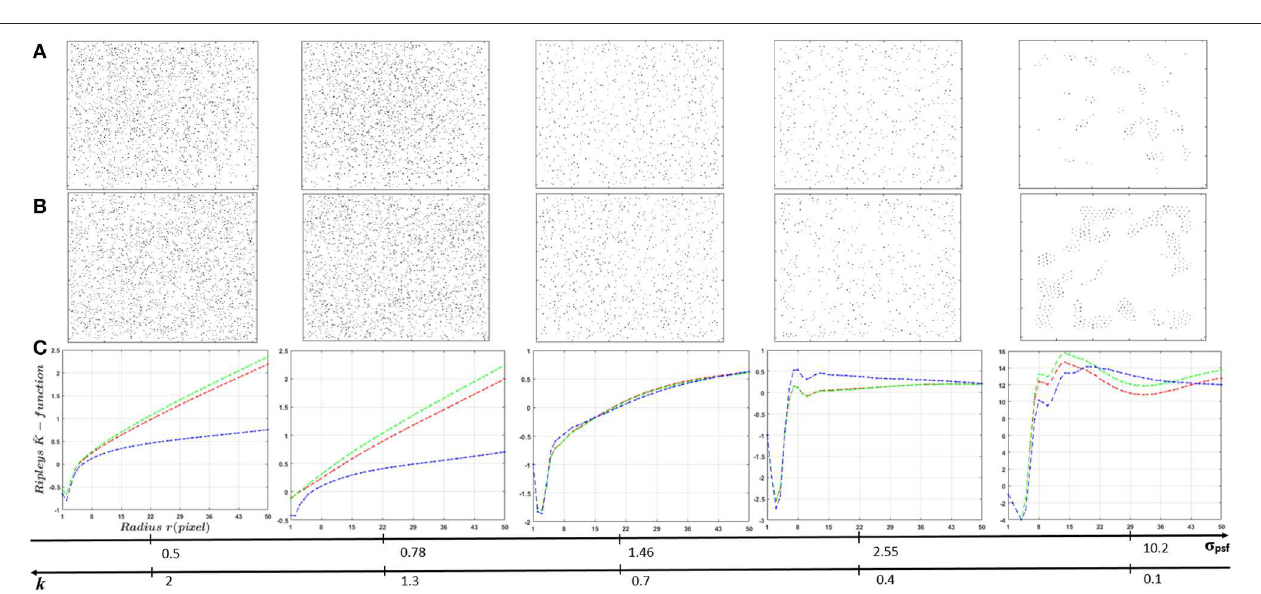
FIGURE 8 | Performance of binary classification for markers spatial organization difference for cell classes C 1 and C 3 as a function of parameter k of Equation (1) for both textural and pointillist approach. The higher k the smaller the PSF size. Standard deviation of performances are computed using 10-folds cross-validation method. In blue, methods following the textural approach, and in pink, methods following a pointillist approach.